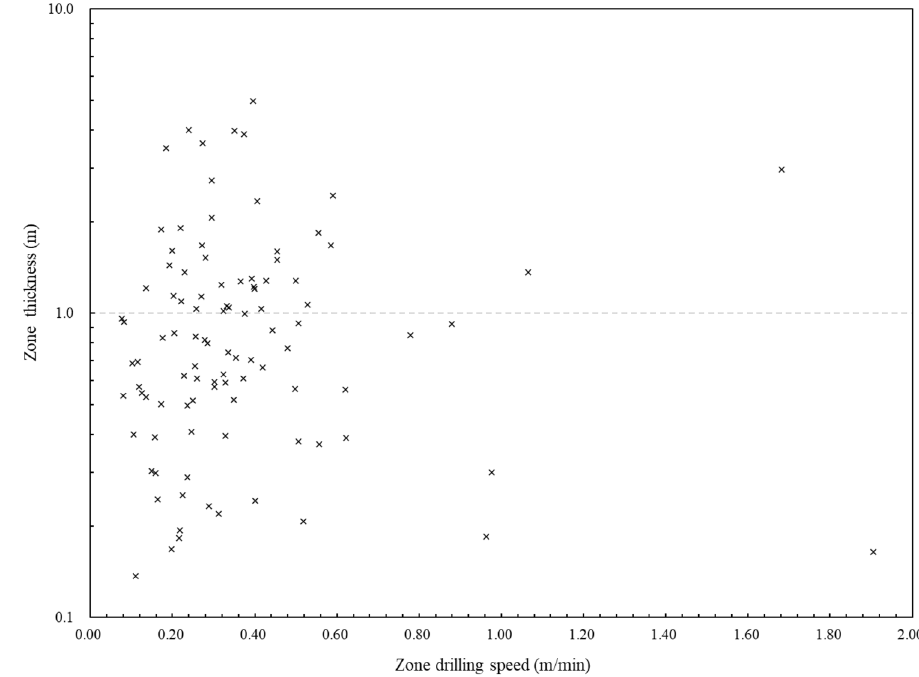
Figure 10. Variations of zone thickness with their corresponding zone drilling speed.